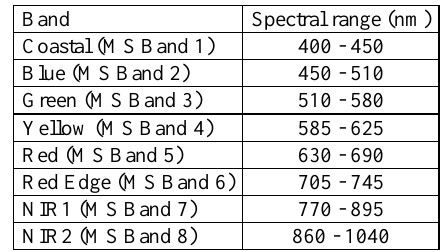
Table 1. Spectral characteristics of Worldview-3